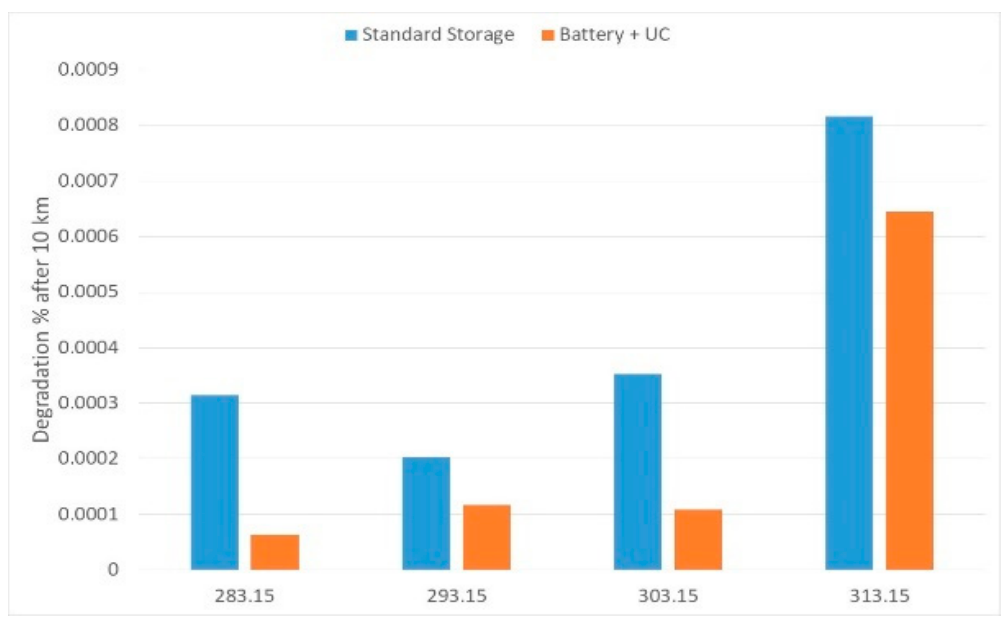
Figure 19. Differences between the standard storage and battery with UCs for the WLTC Class1 with different SOCs.